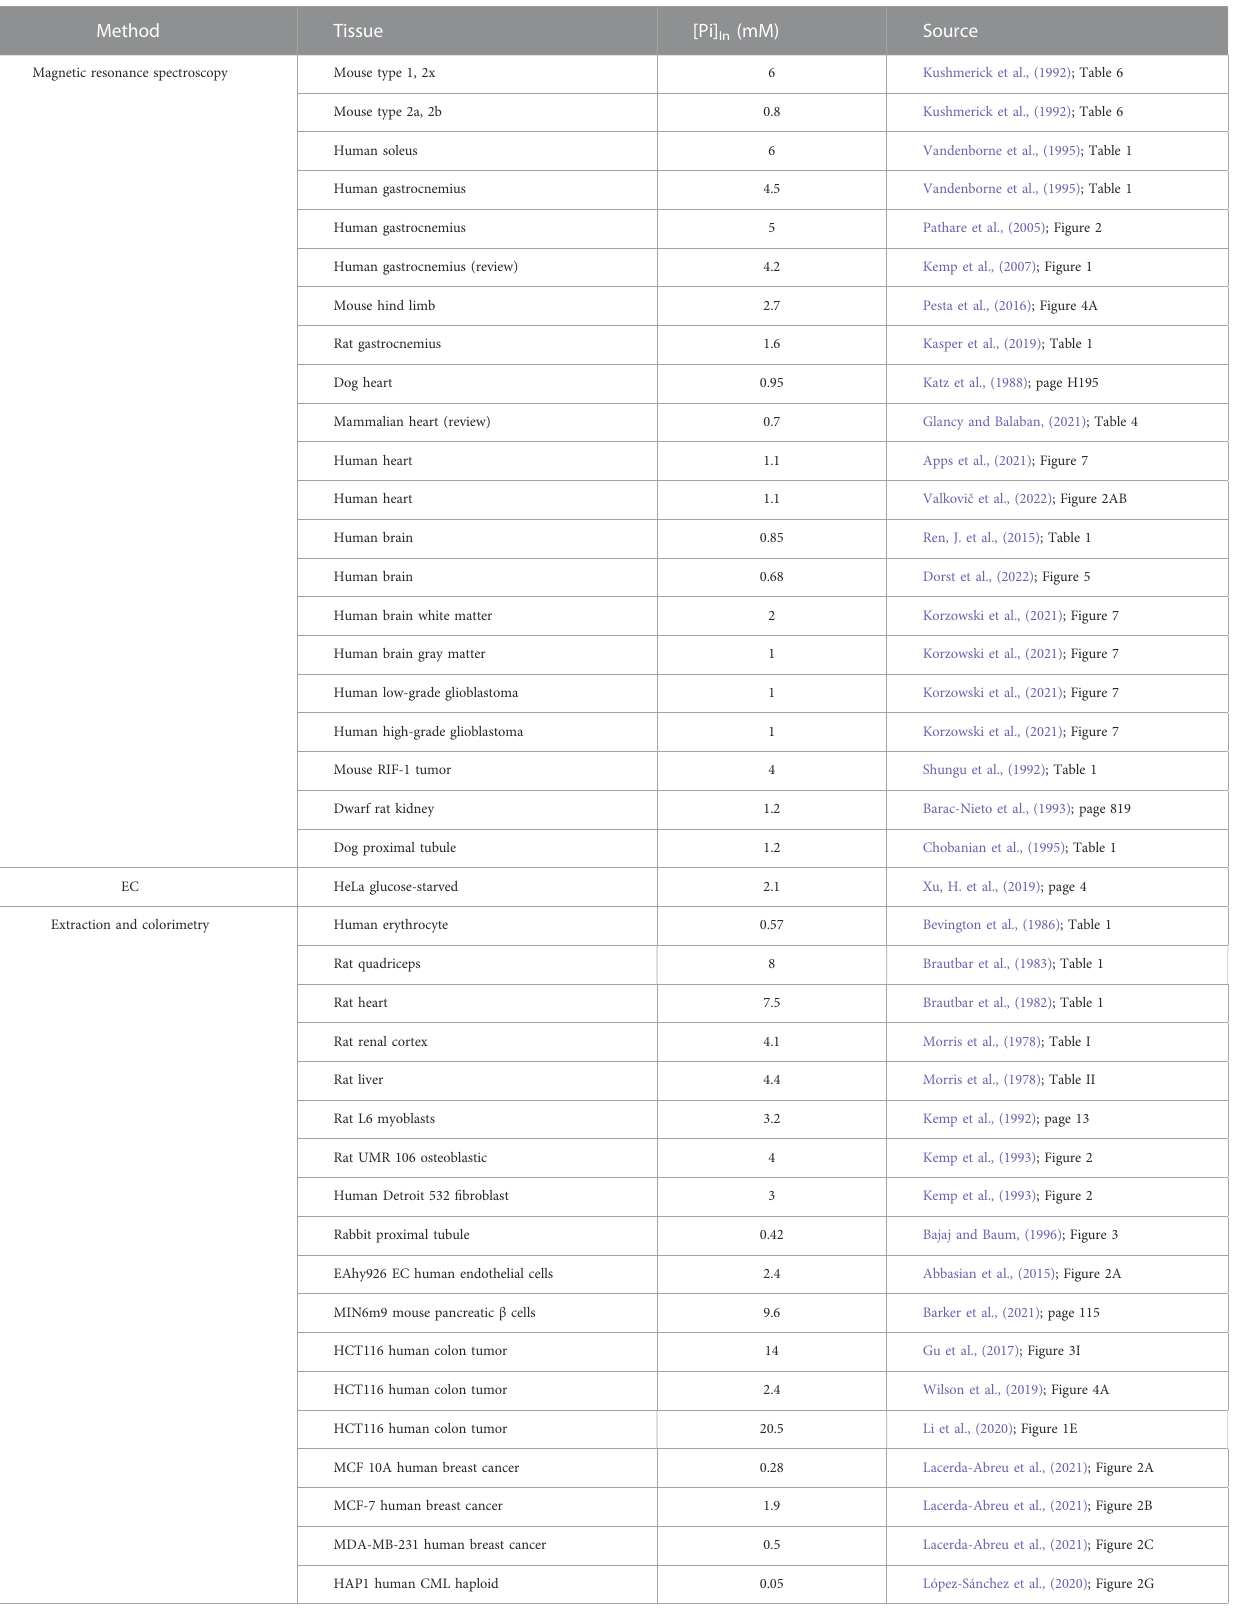
TABLE 1 Partial list of published estimates of mammalian [Pi] In under resting physiological